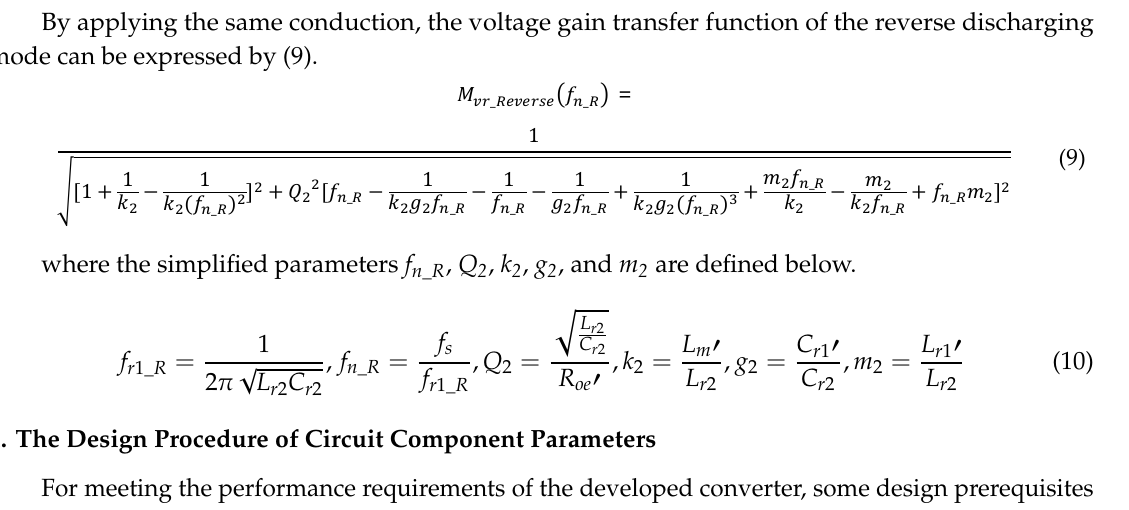
Figure 8. AC equivalent circuit of converter in the reverse operation.